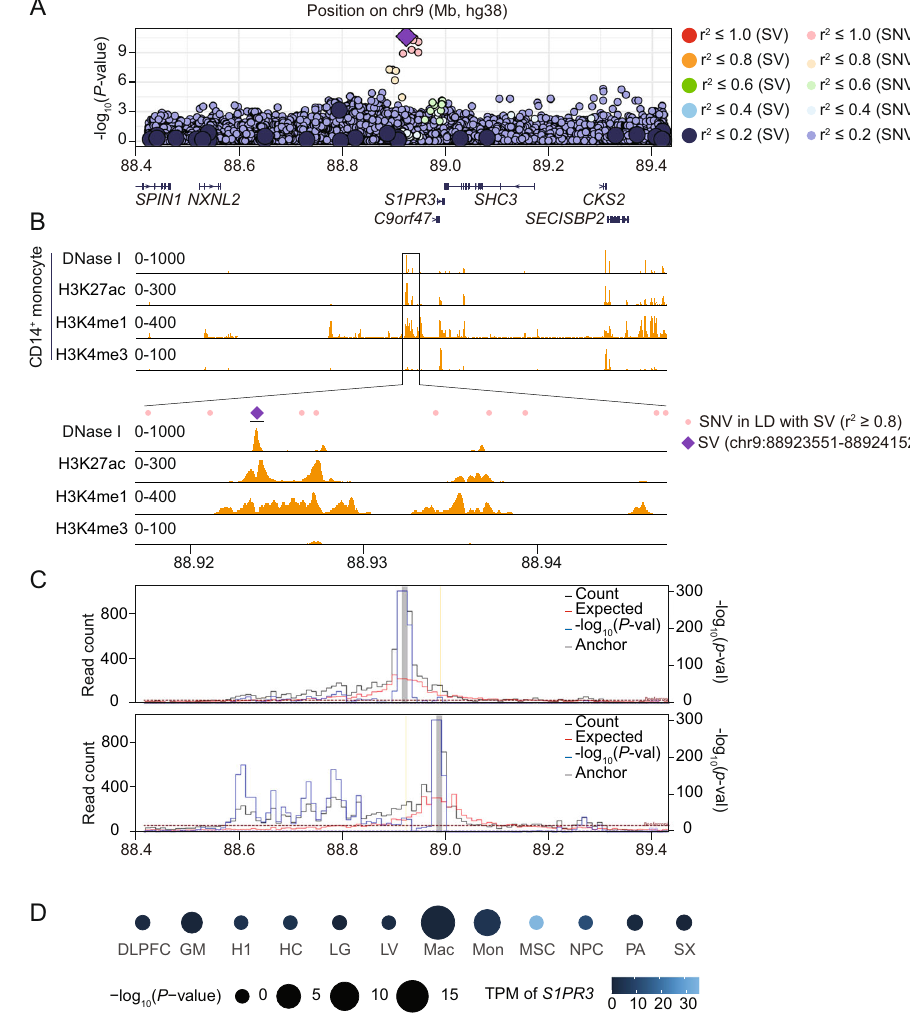
Fig. 1 | A structural variant at human 9q22.1 associated with decreased per- ipheral monocyte count. All p -values are derived from two-sided t-tests and are not adjusted for multiple comparisons. A Genome-wide association -log10( p - values)for9q22.1variantsassociatedwithperipheralmonocytecounts.Thepurple diamond represents the trait-associated deletion (9:88923551-88924152); large circles represent other SVs; and small circles represent single nucleotide variants (SNVs) or indels. Color indicates the linkage disequilibrium (LD) calculated in the analysis sample set between the trait-associated deletion and individual SVs and SNVs. B Distribution of accessible chromatin (by DNase I sequencing) and histone modi fi cations (H3K27ac, H3K4me1 and H3K4me3) in primary CD14+monocytes across indicated genomic regions from ENCODE 26 . C Virtual 4C plot of long-range chromatin interactions anchored at the trait-associated, 9q22.1 deletion (9:88923551-88924152, upper panel) and the S1PR3 promoter region (9:91605763- 91606263,lowerpanel),shownasagreybar,inmacrophages.Yellowlinehighlights the S1PR3 promoter region (upper panel) trait-associated, 9q22.1 deletion (lower